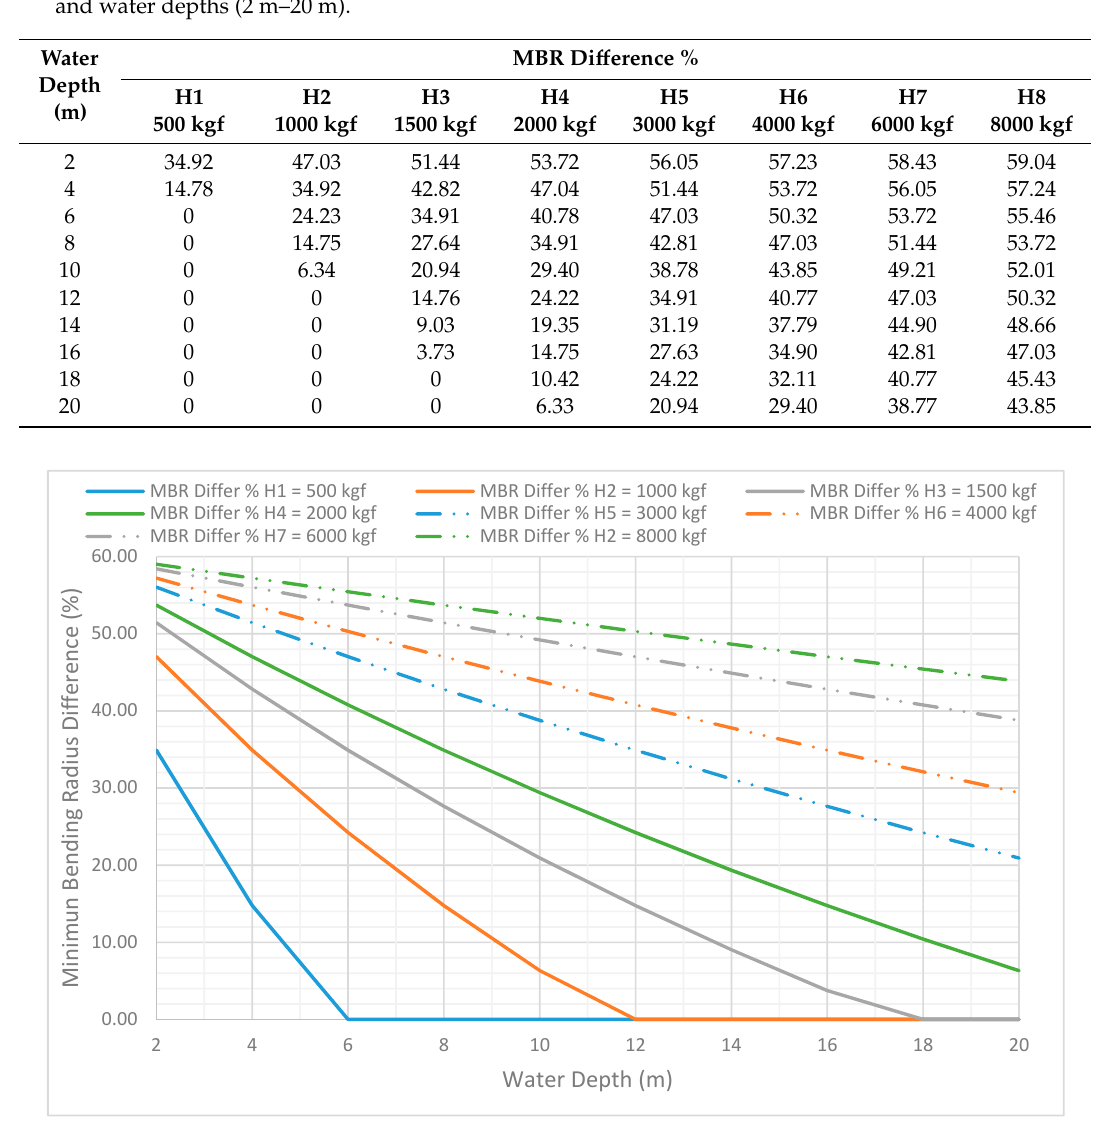
Figure 16. Minimum bending radius difference % comparing CS1 & CS2 using different bottom tensions (500 kgf–8000 kgf) and water depths (2 m–20 m).